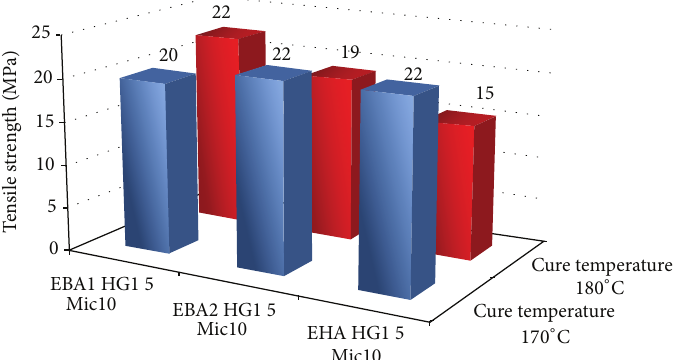
Figure 4: Tensile strength of self-healing epoxy formulations at different curing temperature of 170 ∘ C and 180 ∘ C.